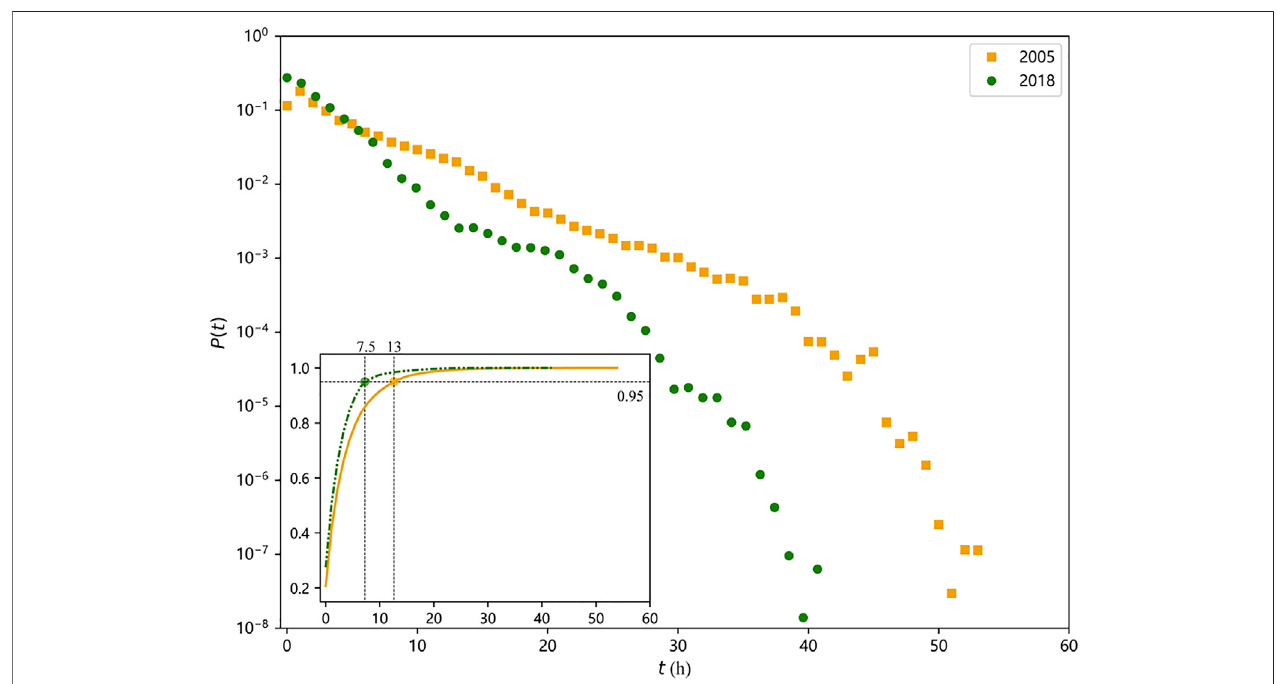
FIGURE 4 | Travel time distribution. The square dot and circular dot in the fi gure represent the proportion of the intercity interaction intensity with a travel time of t hours in 2005 and 2018, respectively. The solid line and dotted lines in the subgraph represent the cumulative probability distribution of travel time in 2005 and 2018,